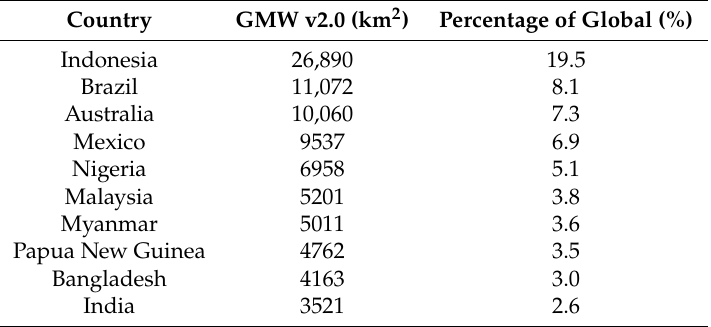
Table 4. GMW v2.0 baseline extents for the world’s Top 10 countries with mangroves.